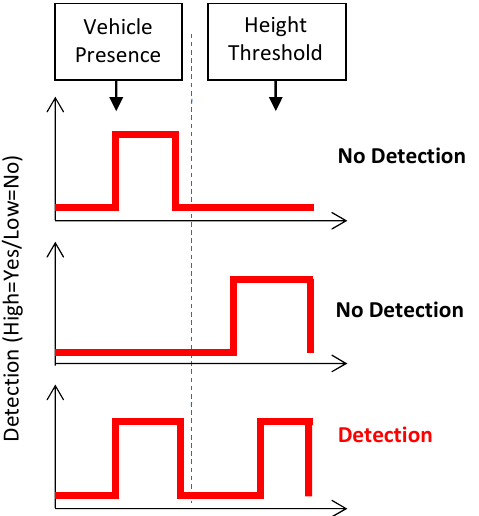
Figure 2. Overall system functionality of the proposed system, describing an overall simplified workflow of a constant loop for detecting whether a vehicle exceeds a height threshold, and how the system will react to such a case.